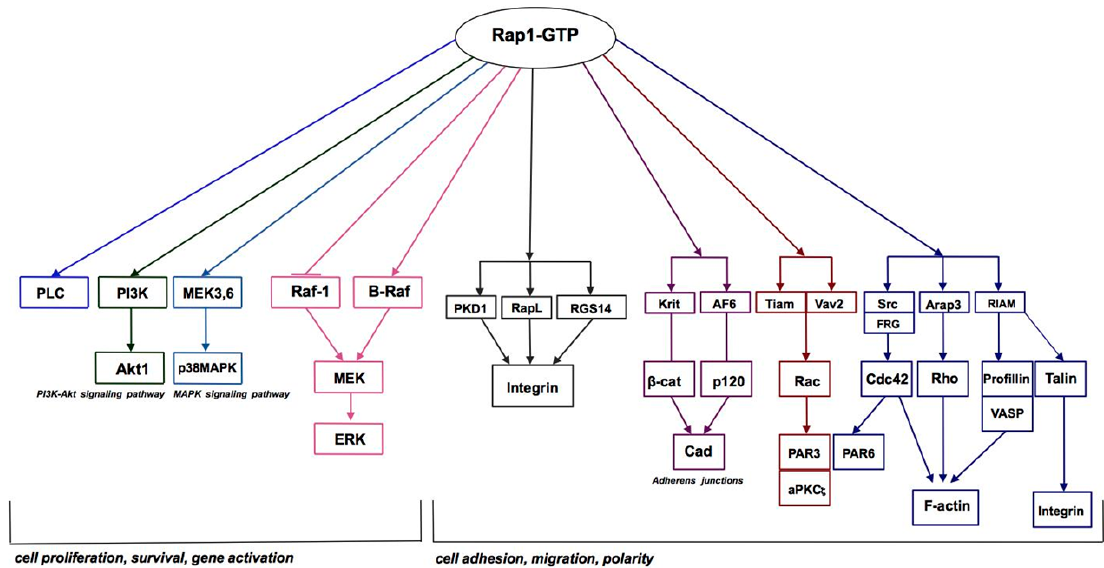
Figure 3. Rap1 GTPase signaling pathways. Based on the KEGG Kanehisa Laboratories (https://www.kegg.jp/kegg-bin/show_pathway?map04015, accessed on 19 September 2018).